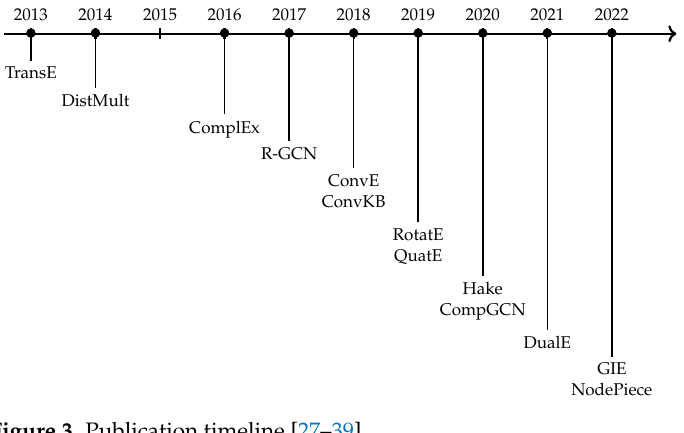
Figure 2. Taxonomy of the reviewed literature and analyzed KG embedding methods [27–39].